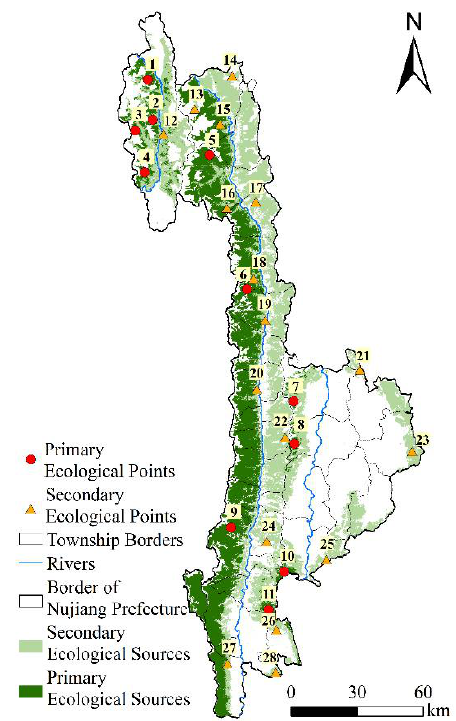
Figure 8. Spatial distribution of ecological points in Nujiang Prefecture.